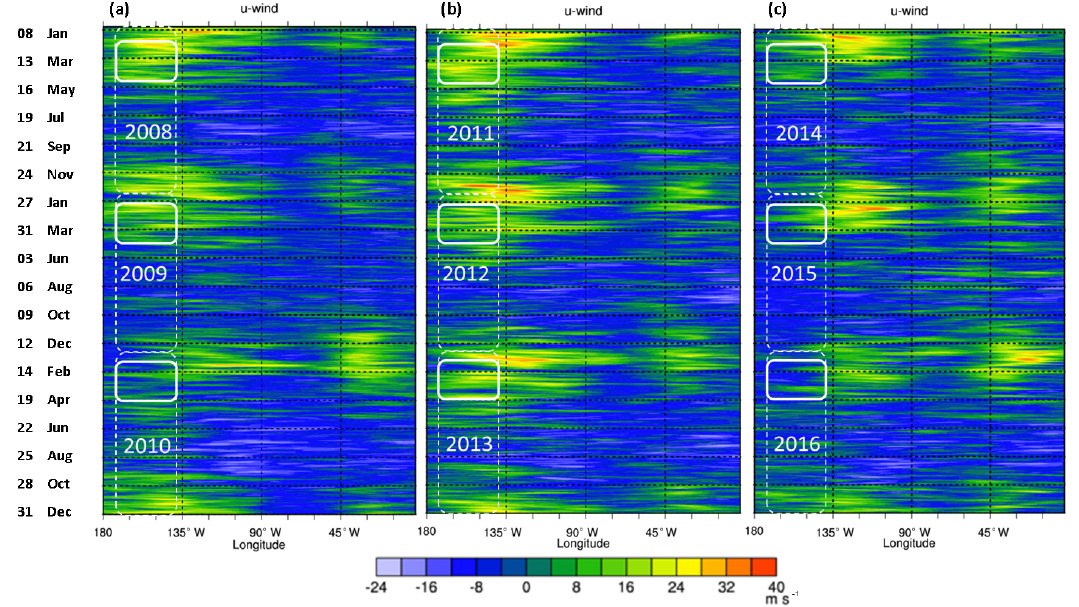
Figure 3. Hovmöller diagrams of 300hPa zonal wind (ms − 1 ) averaged between 5 ◦ S and 5 ◦ N as a function of longitude and time for (a) 1 January 2008 to 31 December 2010, (b) 1 January 2011 to 31 December 2013, and (c) 1 January 2014 to 31 December 2016. Green through to red represent westerly winds ( u winds, ms − 1 ) over the Western Hemisphere. White solid rounded rectangles denote the longitu- dinal extent of the Pacific duct, and the height denotes the February to April period.